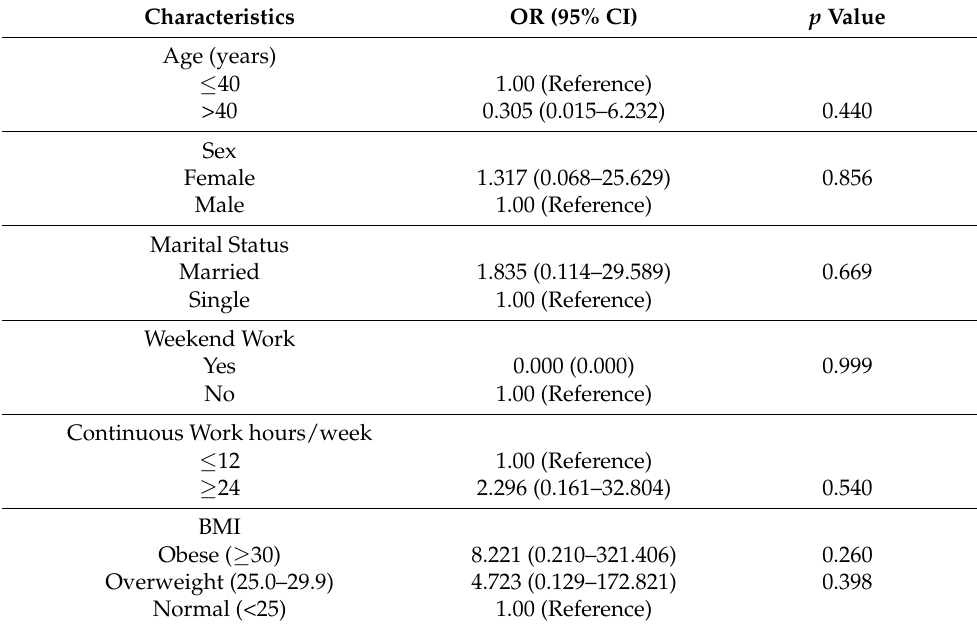
Table 3. Demographic and socioeconomic indicators as risk factors for high